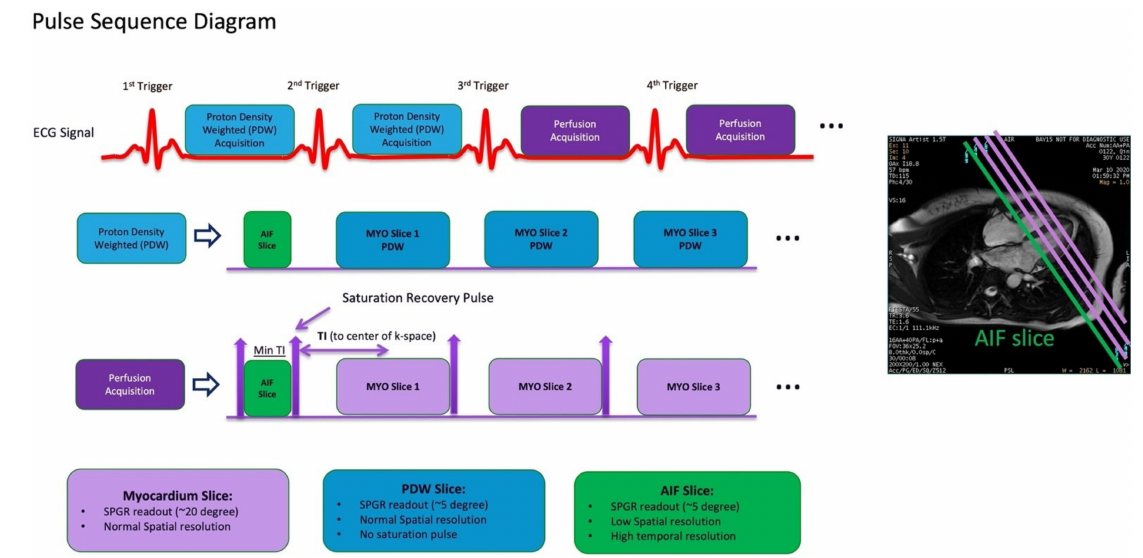
Figure 6. Dual sequence for quantitative myocardial perfusion. Proton density-weighted images are acquired as the first two frames of each slice for surface coil intensity correction. After each R-wave, the arterial input function (AIF) is acquired first, followed by the standard short axis slices. MYO = myocardium. SPGR = spoiled gradient recall.